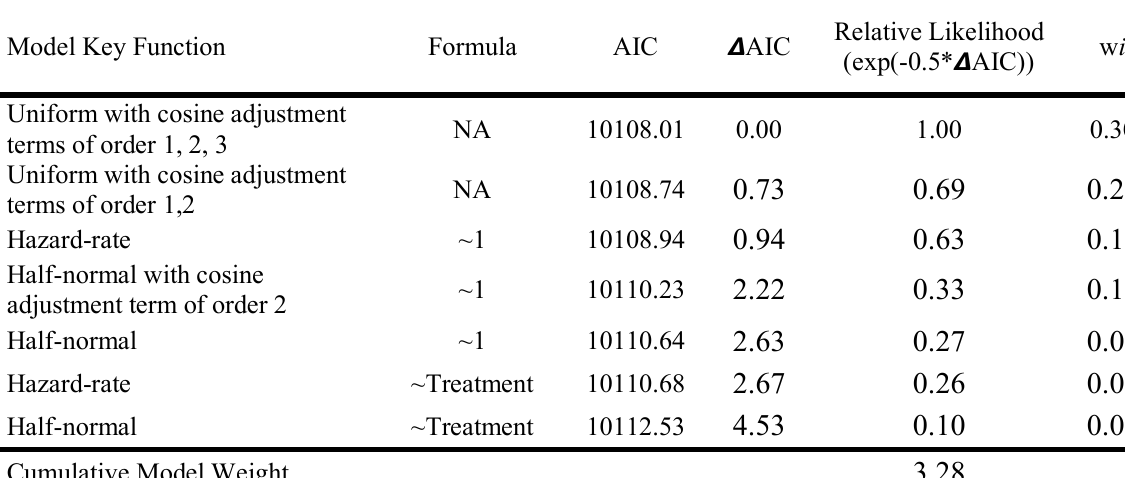
Table S5. AIC table for bird detectability